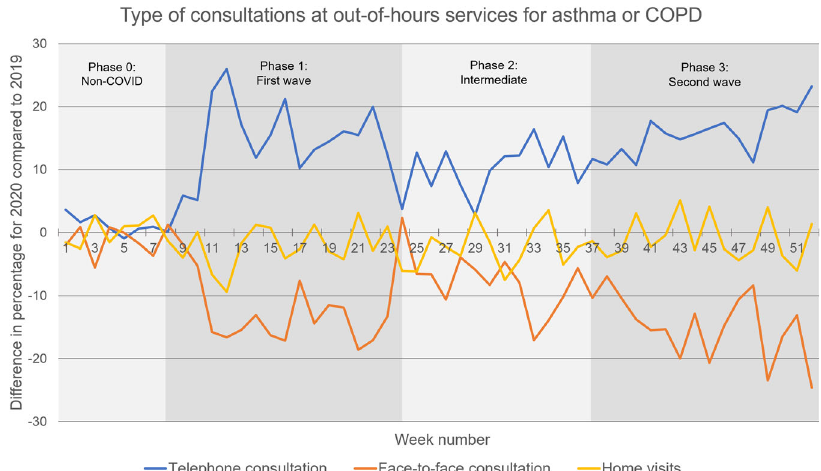
Fig. 3 Type of consultations at out-of-hours services for asthma or COPD. The difference in type of consultation at out-of-hours services for asthma or COPD, 2020 compared to